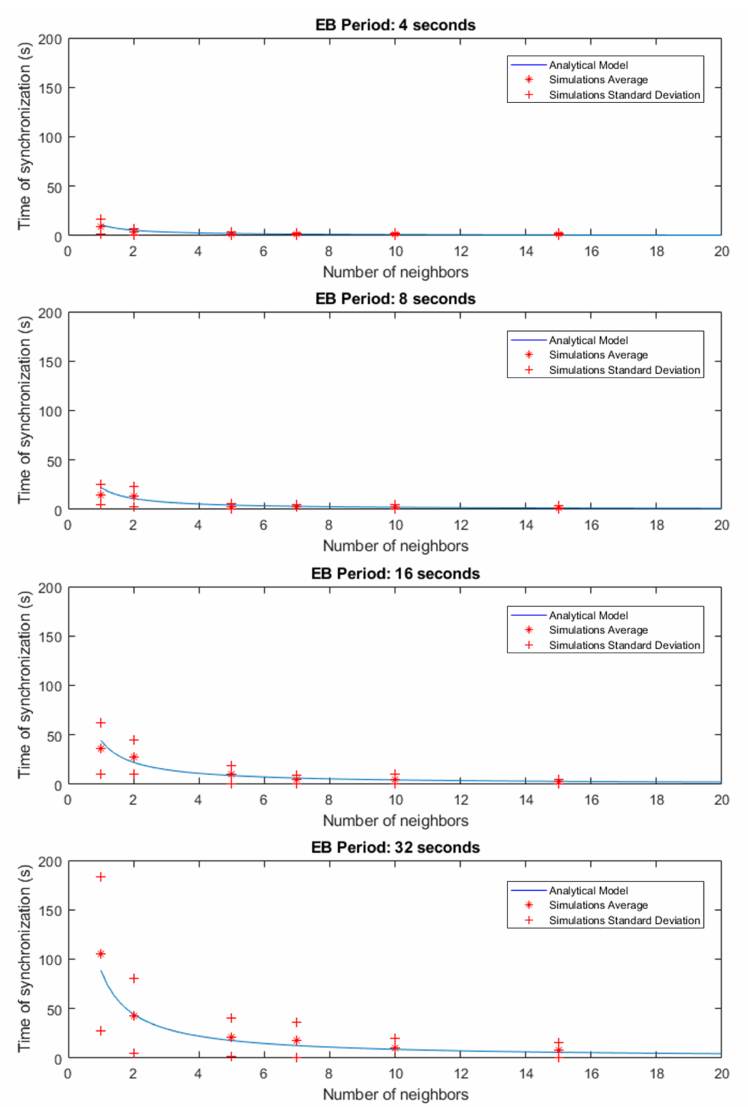
Figure 4. TSCH simulation